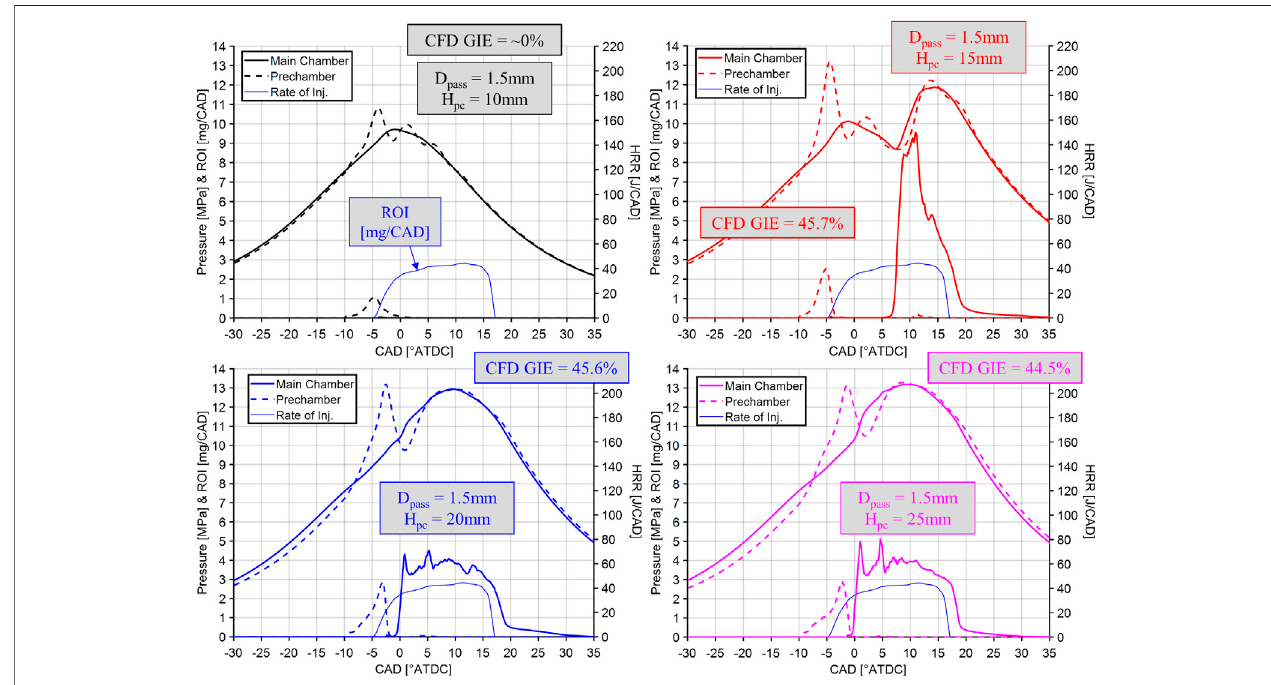
FIGURE 9 | CFD predicted pressure and heat release rate for PC-MCC operation over a parametric sweep of prechamber height. Operation is with pure methanol fuel.